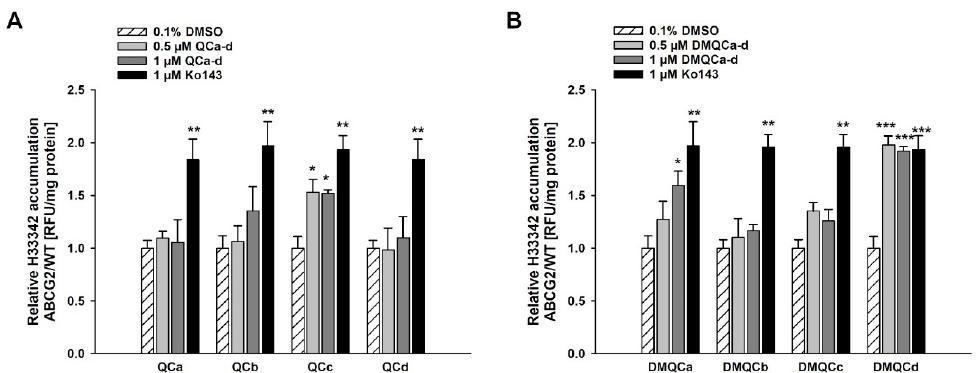
Figure 2. Intracellular Hoechst 33342 accumulation in MDCKII-hABCG2 cells in comparison to MDCKII-WT cells. Cells were treated with ( A ) QCa , QCb , QCc , QCd , or ( B ) DMQCa , DMQCb , DMQCc , DMQCd , or the positive control Ko143. Data were normalized to solvent control (0.1% DMSO) and are presented as mean ± SEM of five independent experiments (N = 5, one-way ANOVA with Holm-Šidák post hoc test, * significant difference in comparison to solvent control: *** p ≤ 0.001, ** p ≤ 0.01, * p ≤ 0.05).